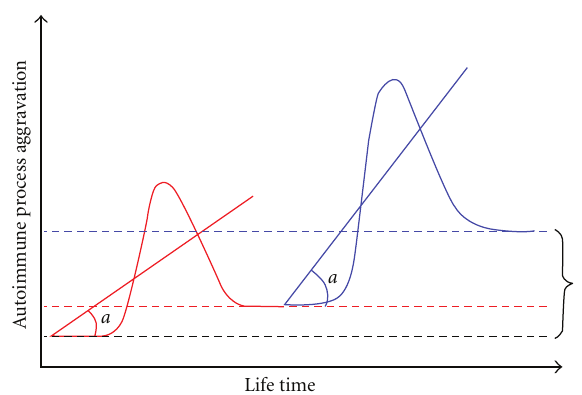
Figure 5: Autoimmune disease aggravation: Y : the individual state of an irreversible immune responsiveness; a : disease degree; (cid:2) i : entropy production, where i represents the number of autoimmune episodes being a time-dependent discrete